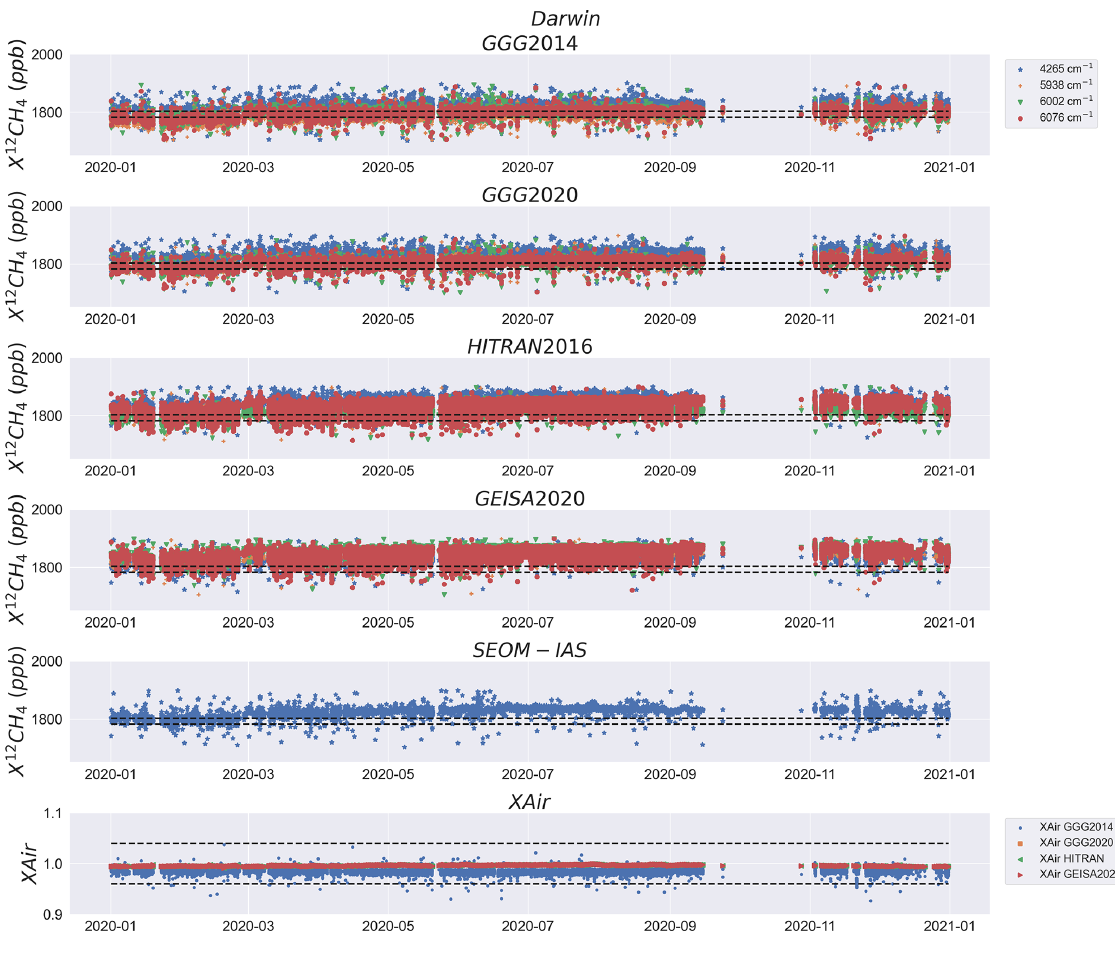
Figure 5. As Fig. 4 but for retrievals from the Darwin TCCON.